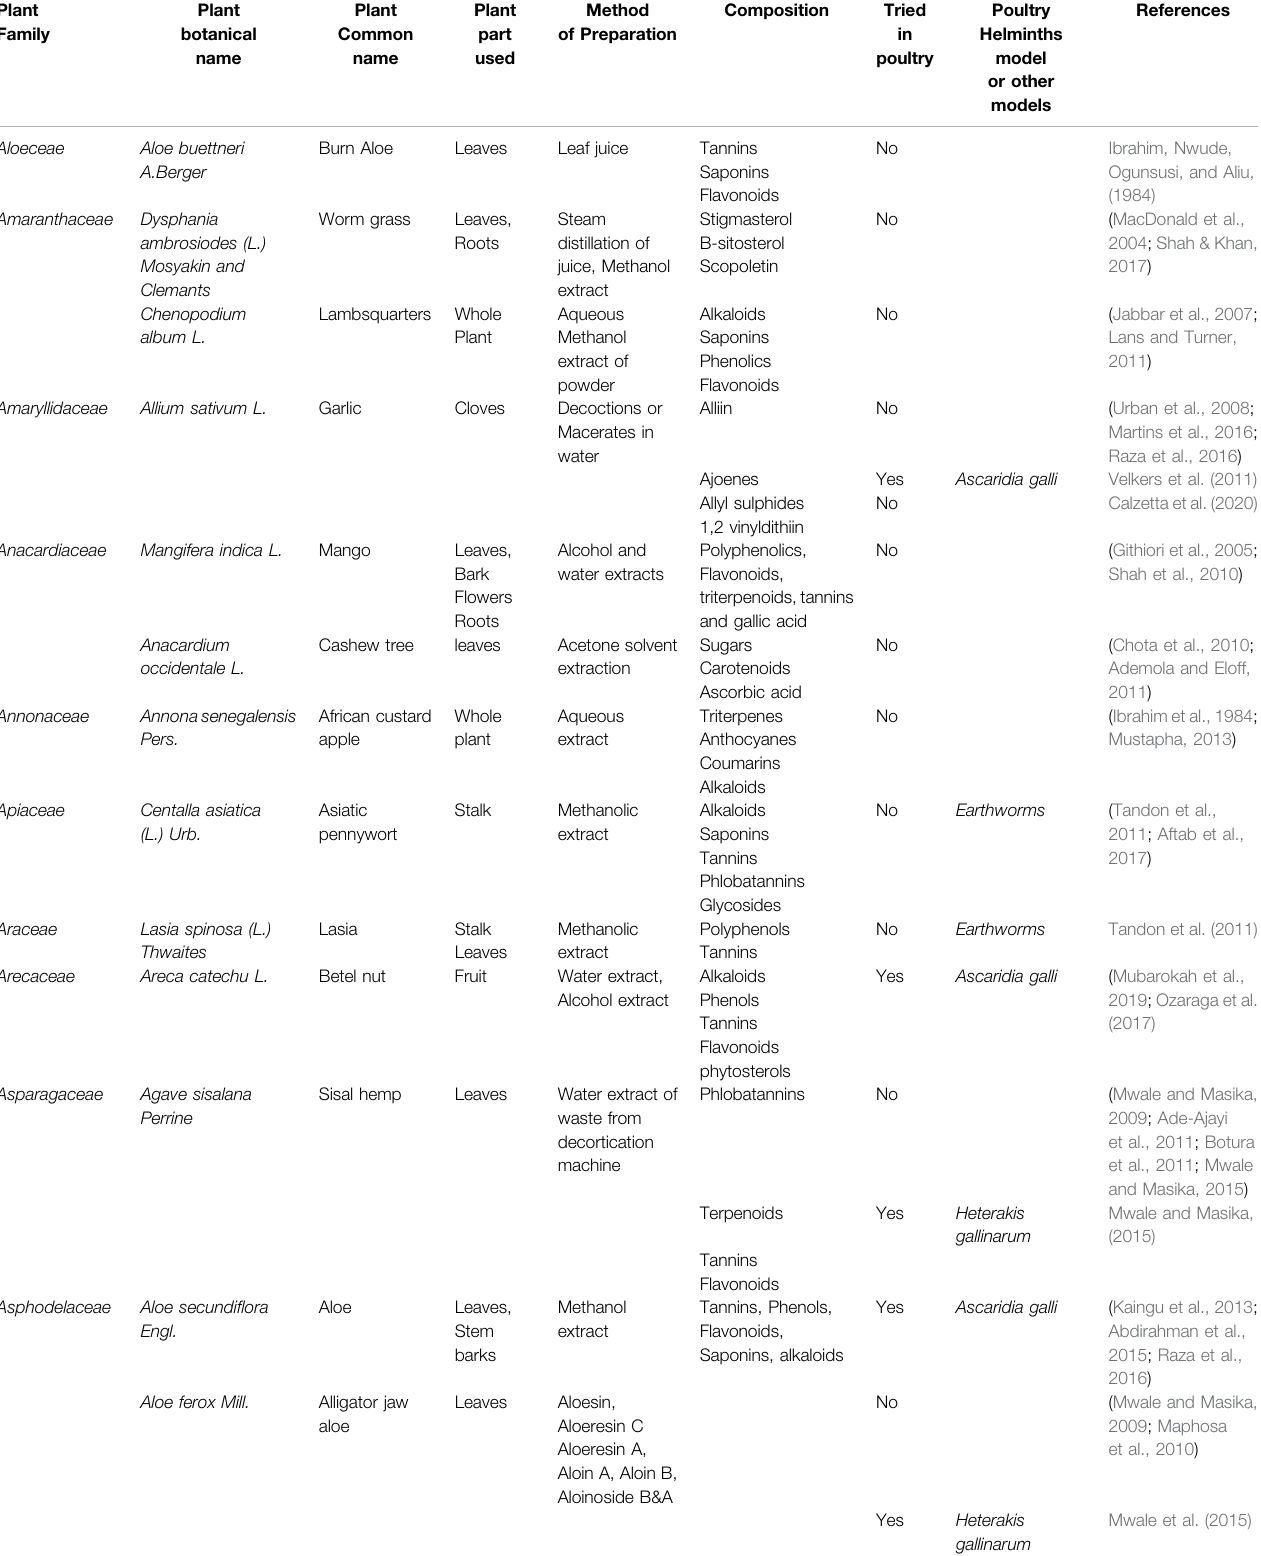
TABLE 2 | Major ethnoveterinary options for control of helminths, preparation, composition and target vector species. Leaves, roots and stems have been used on limited helmintic species, however studies on their pharmacology remain scarce. Information on effective dosage, effective concentration and safety are still unknown. Plant